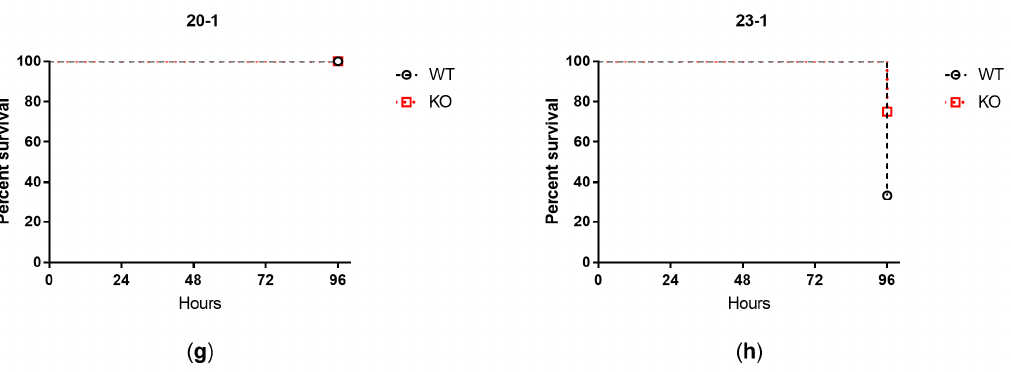
Figure 4. Percent survival of WT and KO mice up to 96 h after intratracheal challenge with each clinical isolate: 2-4 ( a ), 7-2 ( b ), 8-2 ( c ), 12-2 ( d ), 16-1 ( e ), 17-1 ( f ), 20-1 ( g ), 23-1 ( h ). The mean of four mice per group is shown. Statistical analysis was performed by log-rank test; * p < 0.05.